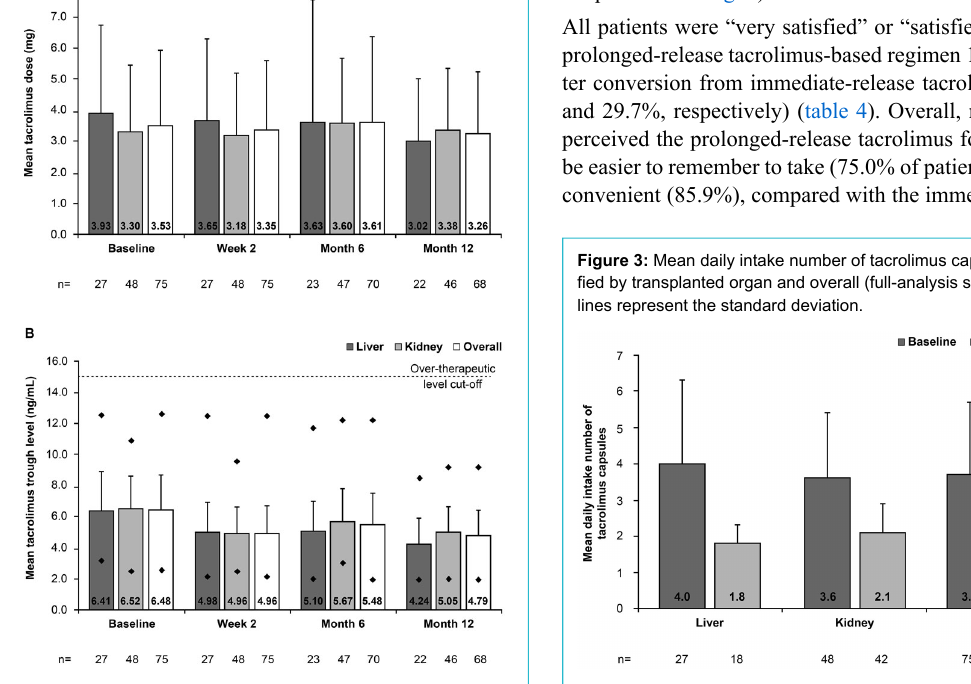
deviation. In figure 2B, diamonds represent the minimum and max- imum tacrolimus trough level recorded at each visit.